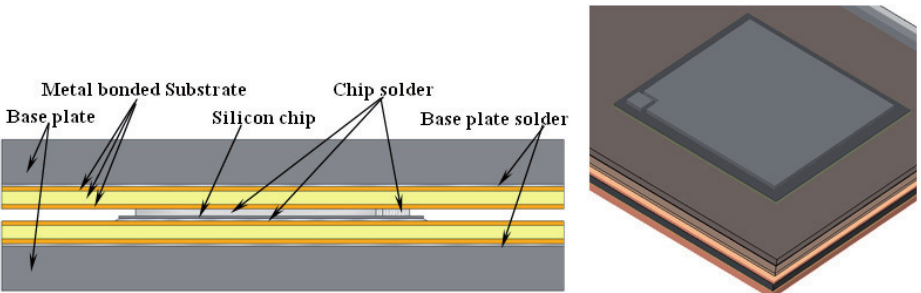
Fig. 10. Direct Solder (DS) assembly (ABB 1200 V – 150 A chip).